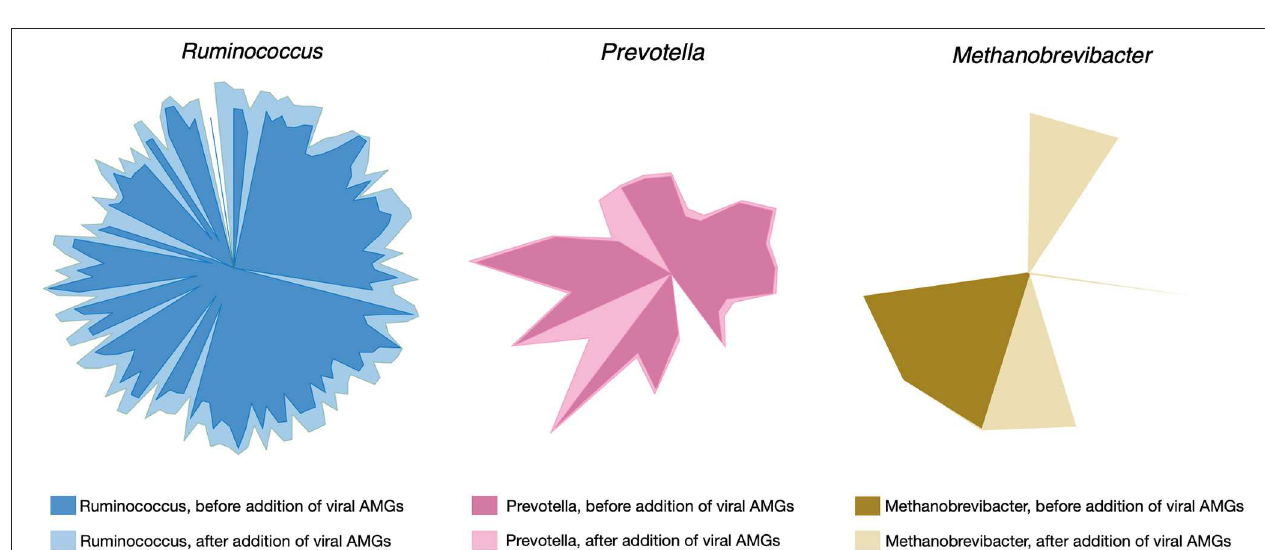
FIGURE 3 | Changes in flux space after viral AMGs were added to the metabolic models. The lighter shade for each of the colors represent the relaxed flux space after addition of AMGs in each of the microbial metabolic models.